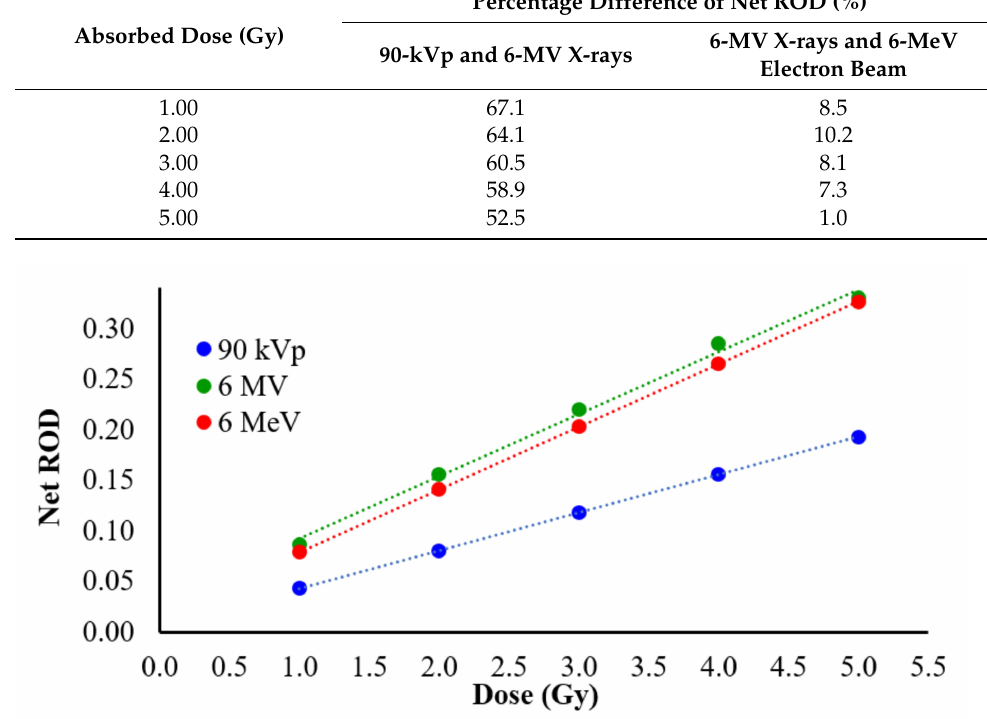
Figure 5. Energy dependence of the expired EBT3